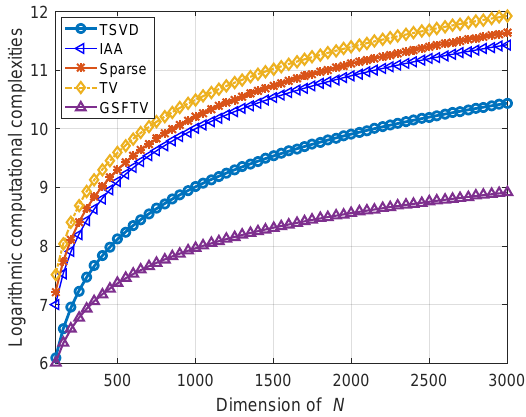
Figure 2. Logarithmic computational complexity